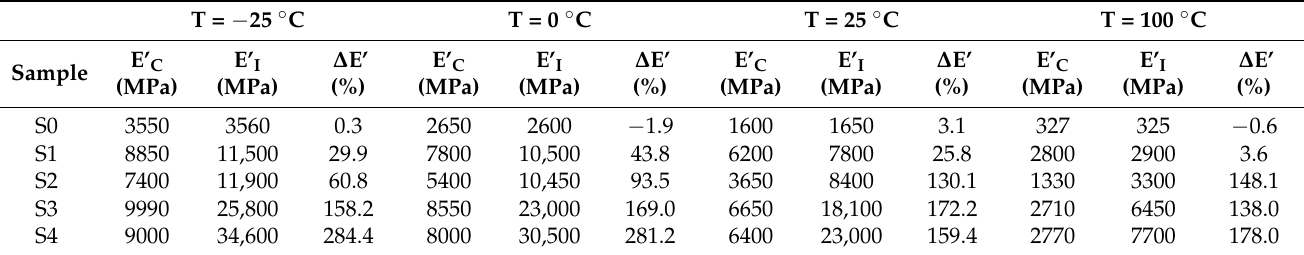
Table 5 . Storage Modulus (E’) obtained from the indicated molded compounds obtained under Compression (E’ C ) and Injection conditions (E’ I ) for the indicated temperatures.